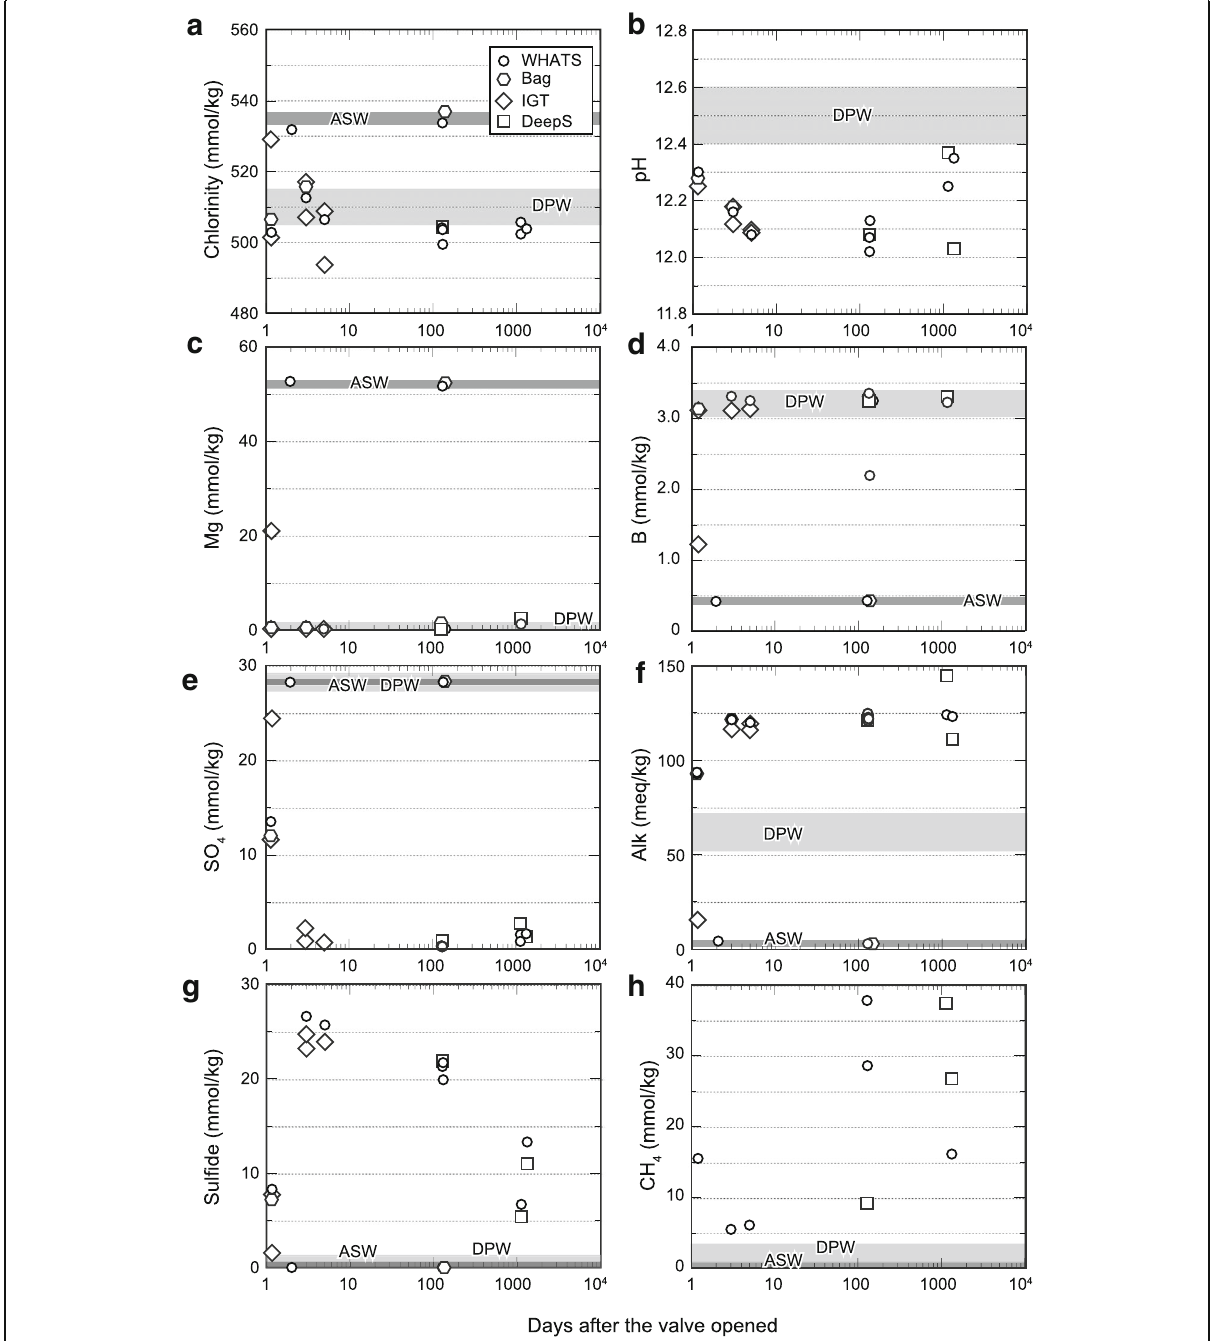
Fig. 3 Time-series of fluid chemistry since the valve opening. Light and dark gray bars represent the deep part of the ODP porewater at Site 1200 (DPW) (Mottl et al. 2003) and ambient seawater (ASW) composition, respectively. Each symbol represents a type of fluid sampler used: WHATS (circle), Bag (hexagon), IGT (diamond), and Deep Sampler (square). Time ( x axis) is in logarithmic